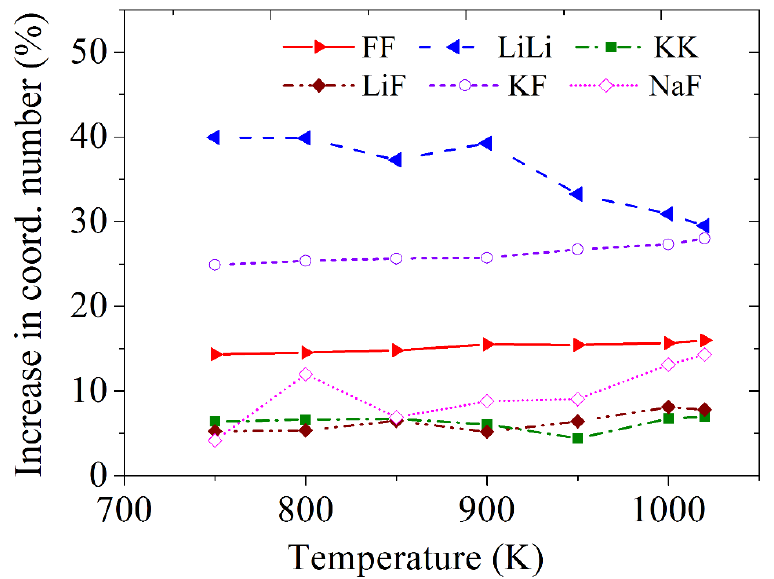
Figure 9. Temperature dependence of the increase (in %) in the values of the coordination numbers of ions in the molten salt mixture FLiNaK+15 mol.% CeF 3 with respect to pure molten FLiNaK.